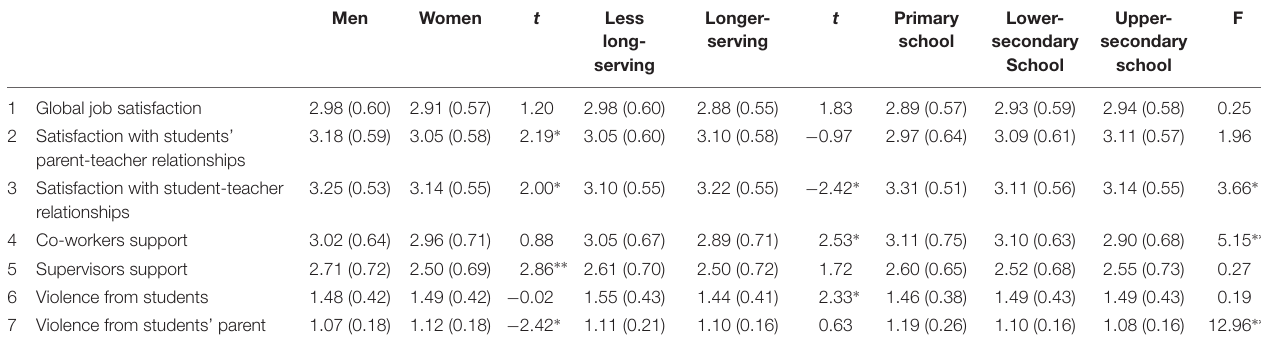
TABLE 2 | Differences in the sample means ( N =